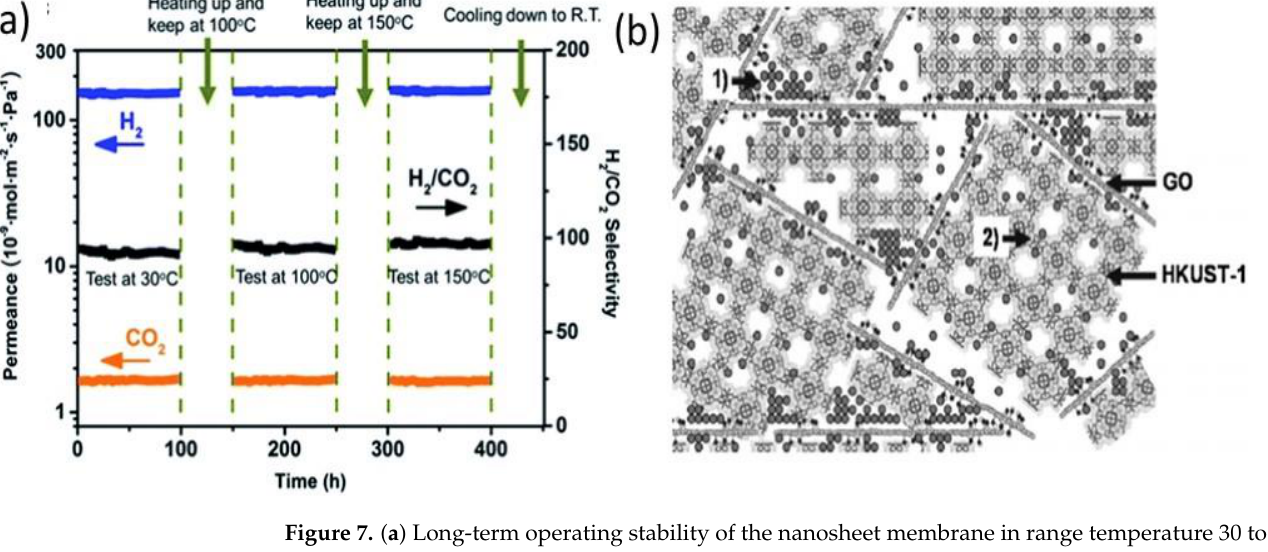
Figure 7. ( a ) Long-term operating stability of the nanosheet membrane in range temperature 30 to 150 ◦ C and ( b ) visualization of ammonia adsorption site in the composite: (1) physisorption at the interface between graphene layers and (2) binding to the copper centers. Ammonia molecules are represented by grey circles. Reproduced with permission from [19,21]. Copyright 2018, Elsevier and Royal Society of Chemistry.